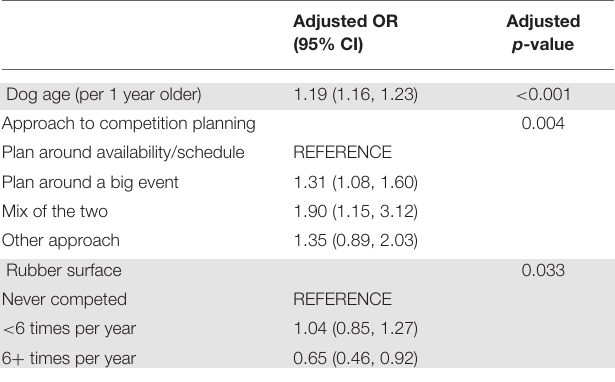
TABLE 3 | Coefficients from adjusted model with competition level factors only for severe